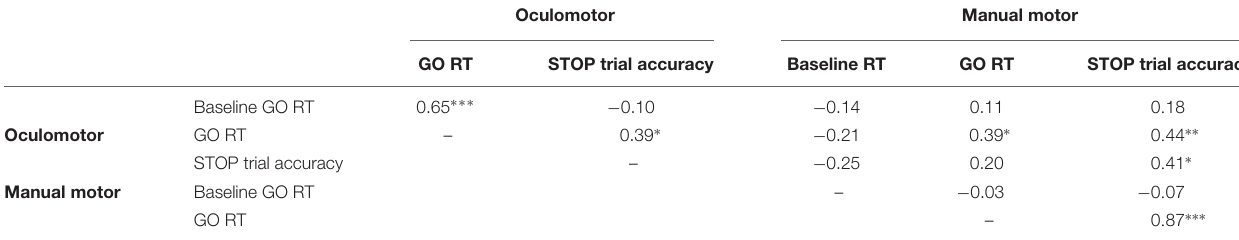
TABLE 2 | Relationships between oculomotor and manual motor reaction times and stopping accuracy.